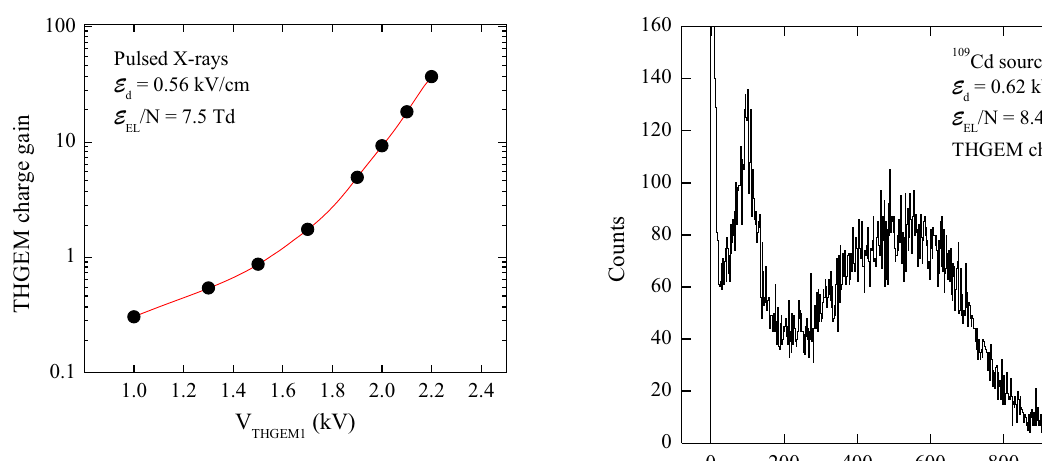
Fig. 13 THGEM/SiPM-matrix readout: charge gain of the THGEM1 multiplier as a function of the voltage across it, at fixed electric fields in the drift and EL regions